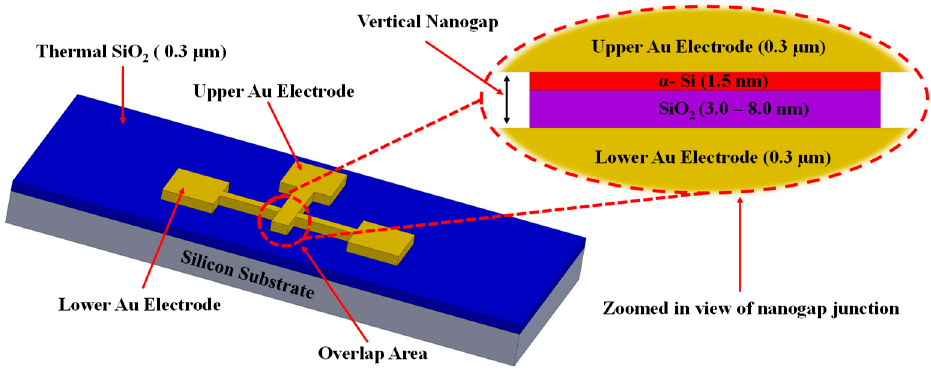
Figure 2. 3D schematic of the device of vertical nanogap structure and zoomed-in view of a sacrificial spacer layer.